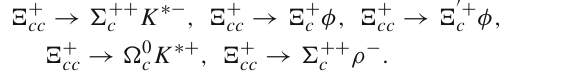
Table 3 Our results for decay widths of (cid:2) + cc → B c V and correspond- ing topological contributions. The “CF”, “SCS” and “DCS” represent CKM favored, singly CKM suppressed and doubly CKM suppressed